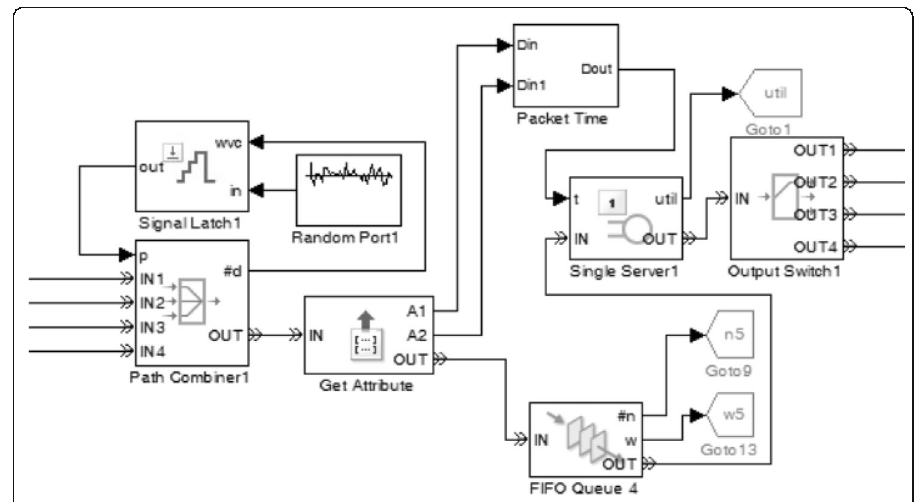
Fig. 8 Snapshot of access point as implemented in MATLAB Simevent